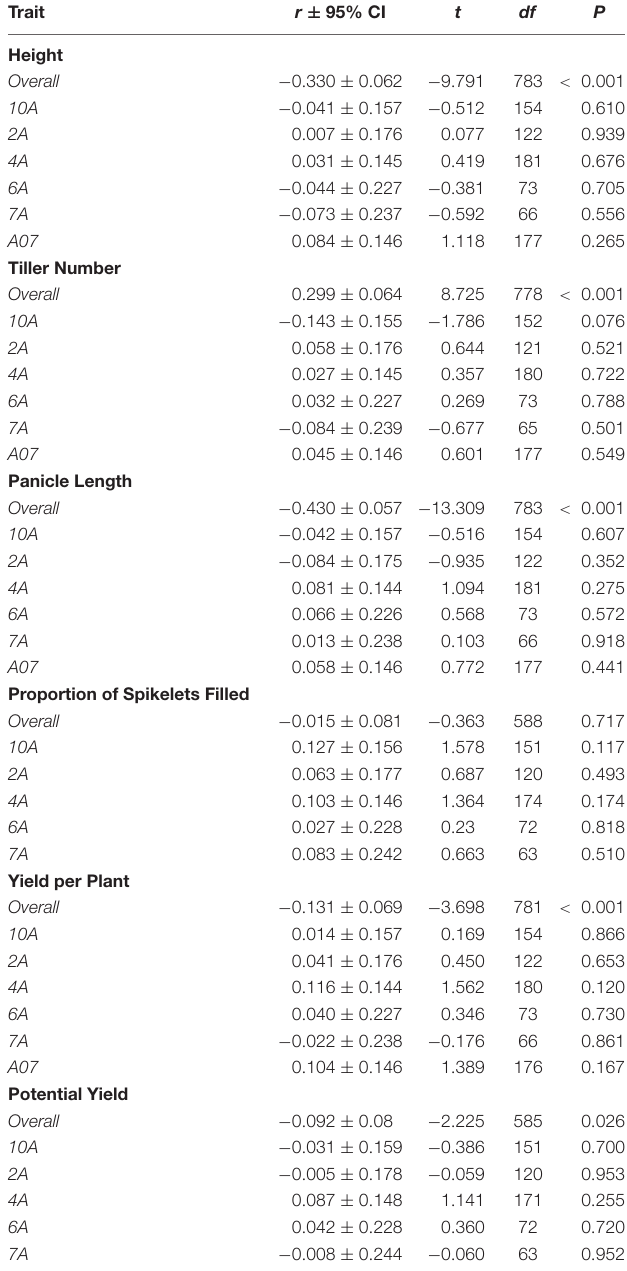
TABLE 10 | Pearson’s correlation coefficient of mid-parent heterosis and SDAF with 95% confidence intervals of the coefficient and t -tests of significance conducted at α =